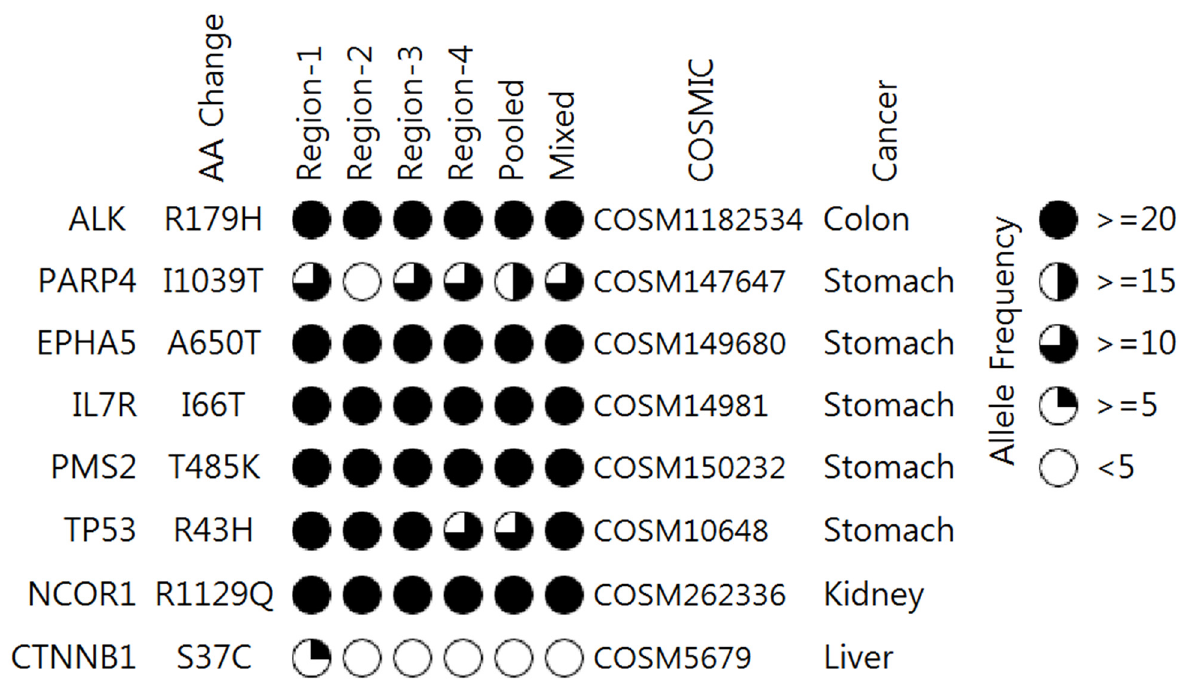
Fig 4. Profile of variants listed on the COSMIC DB and labeled as the same tissue type. The fraction of each circle indicates tumor variant allele